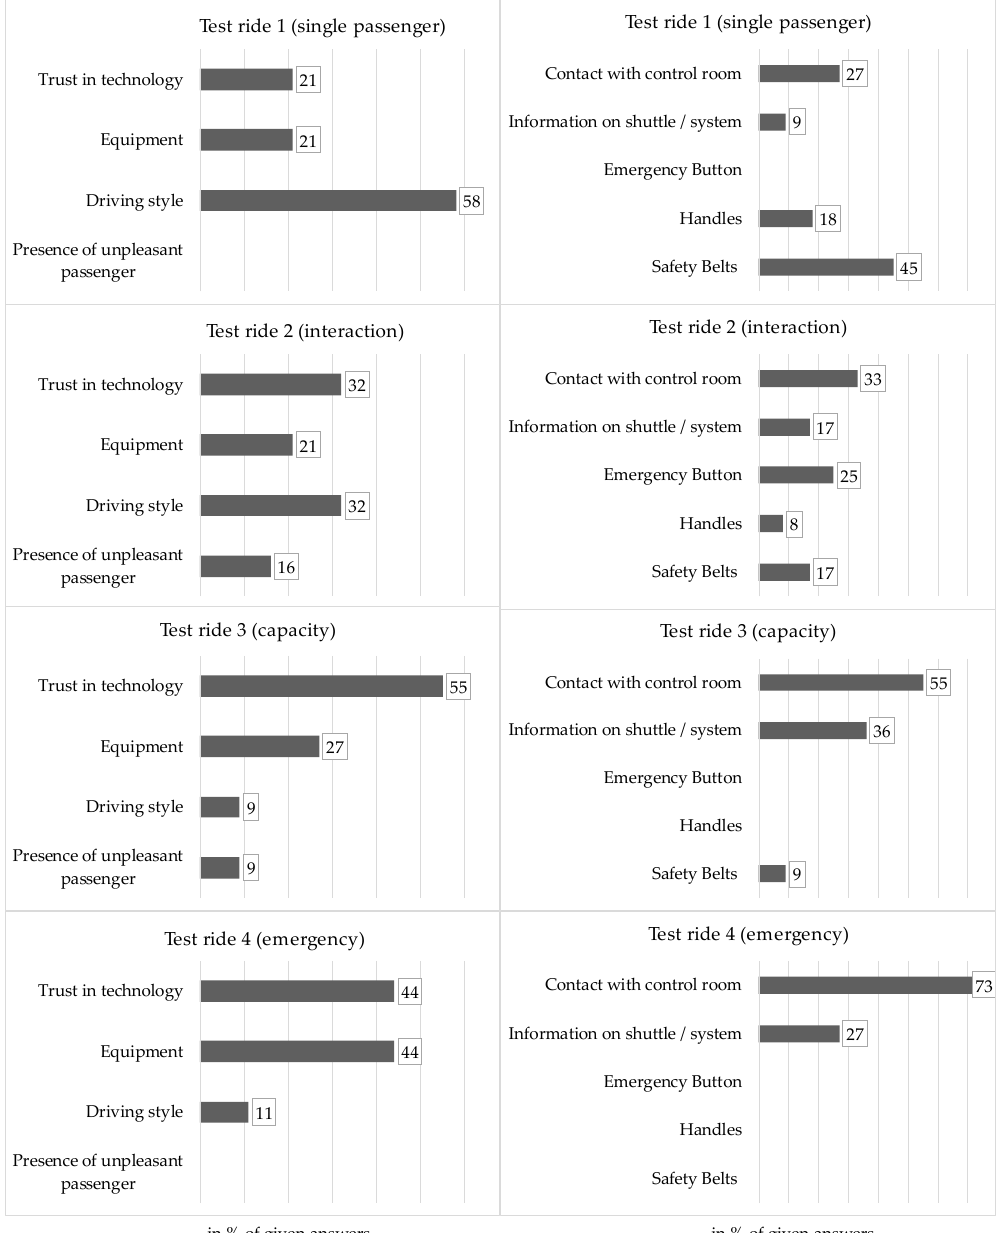
Figure 5. Results per test ride (% of given answers). Left panel shows responses to the question: “What has influenced your feeling of safety?”, right panel shows responses to the question: “What would contribute to your feeling of safety?”.